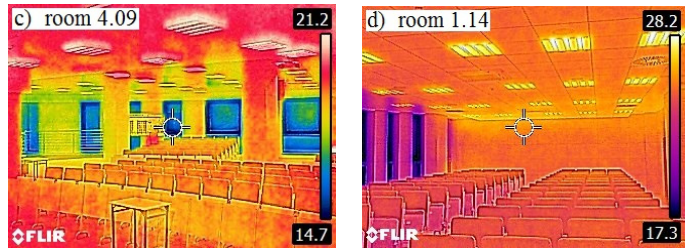
Figure 3. Energis: thermal images of the Northern ( a ) and Southern ( b ) façades as well as lecture rooms on the fourth ( c ) and first floor ( d ).